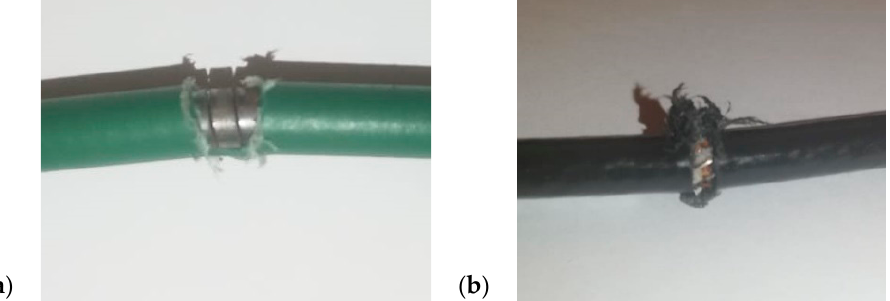
Figure 8. Waterjet cutting without abrasive examples for a laminated spiral without inner tube ( a ) and a braided spiral ( b ). ( a ) and a braided spiral ( b ).